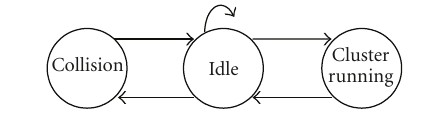
Figure 3: Slot and Superslot Definition.